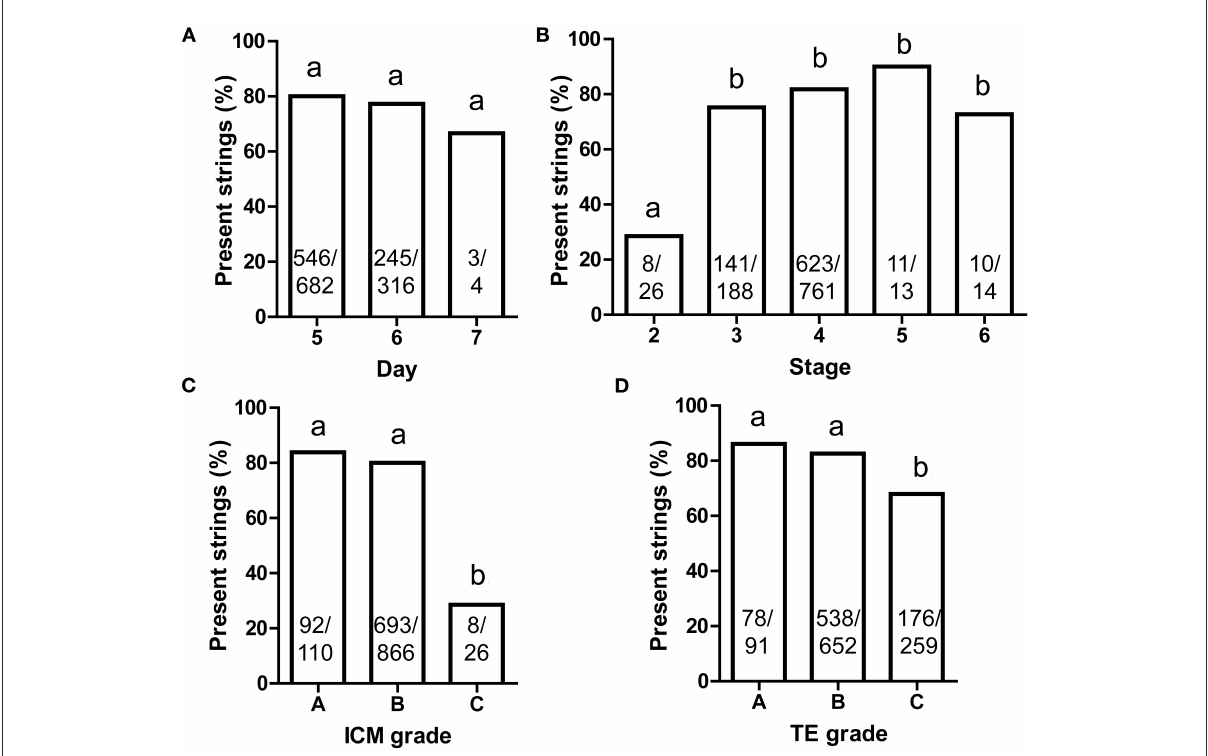
FIGURE3 The present frequency of cytoplasmic strings between ICM and mTE cells. (A) Different blastocyst ages; (B) different blastocyst stages; (C) different ICM grades; (D) different TE grades. Throughout, multiple Chi-square analysis was performed (A–D) and the same superscript lowercase letters indicated no statistical differences in the intergroup comparisons ( P > 0.05). ICM, inner cell mass; mTE, mural trophectoderm. The sample size was presented on each